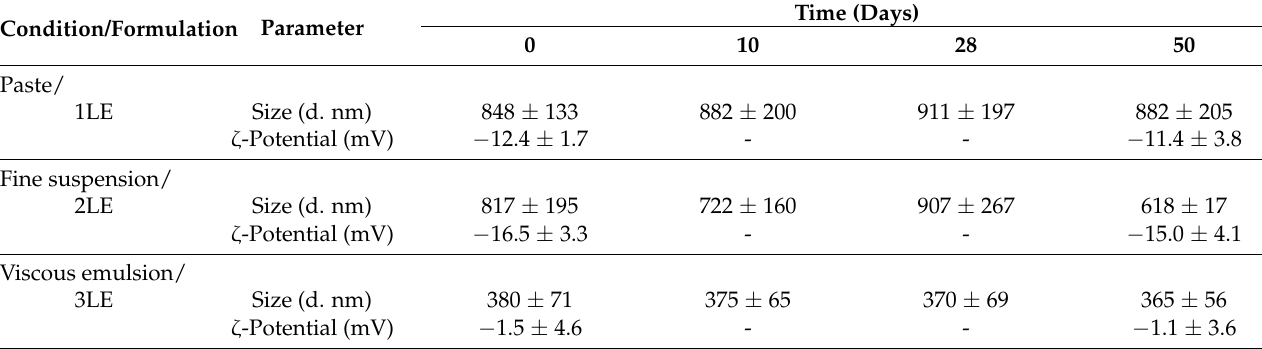
Table 6. Particle sizes and ζ -potentials during storage for the formulations of lutein esters with PSM, PSM, and MCT oil, or lecithin (formulations 1LE, 2LE, and 3LE,